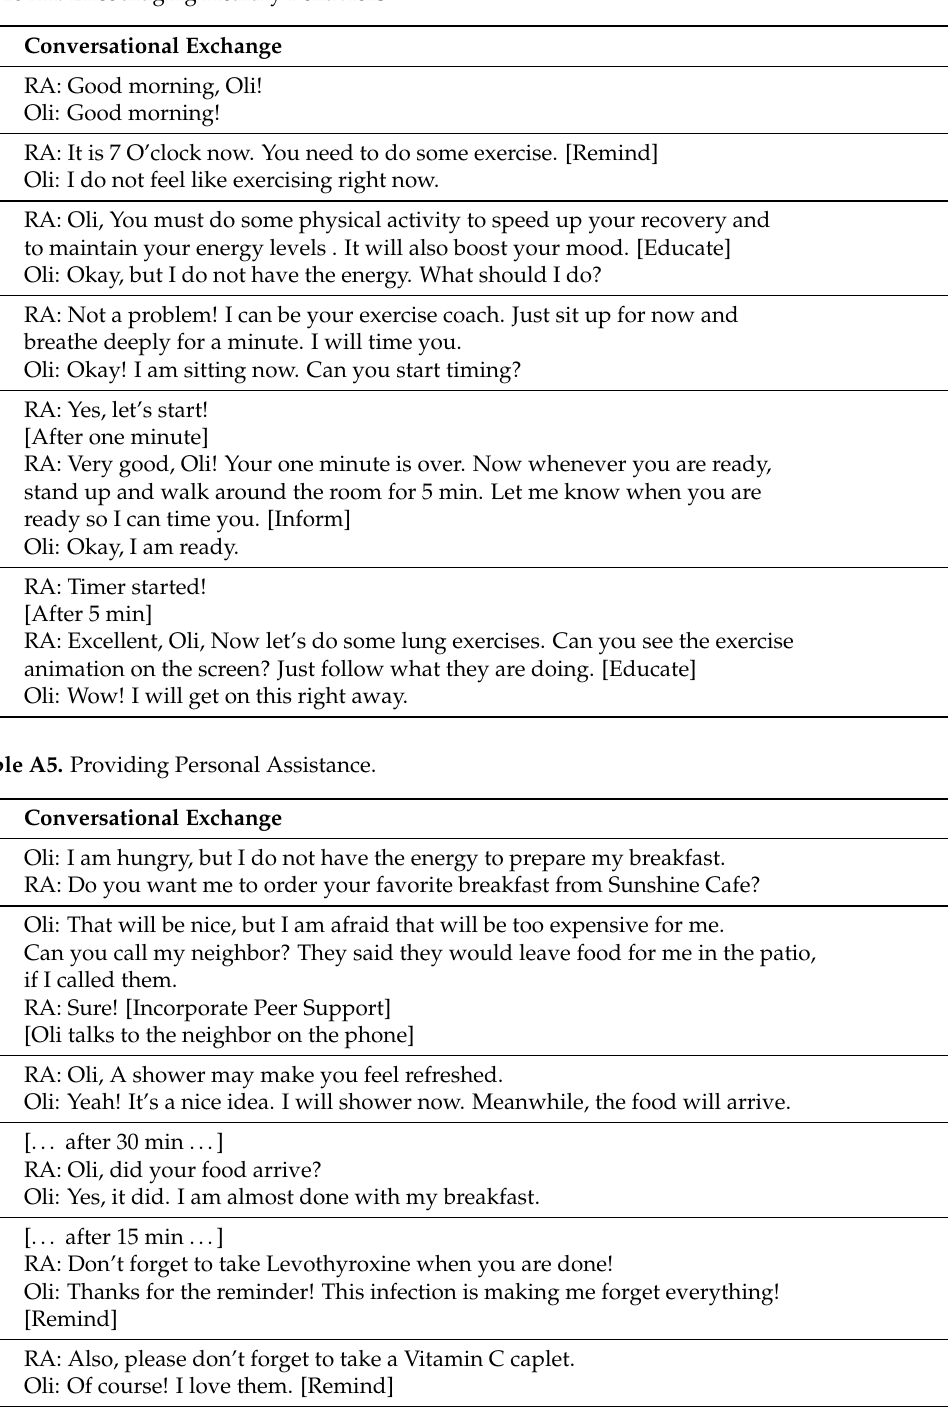
Table A4. Encouraging Healthy Behaviors.